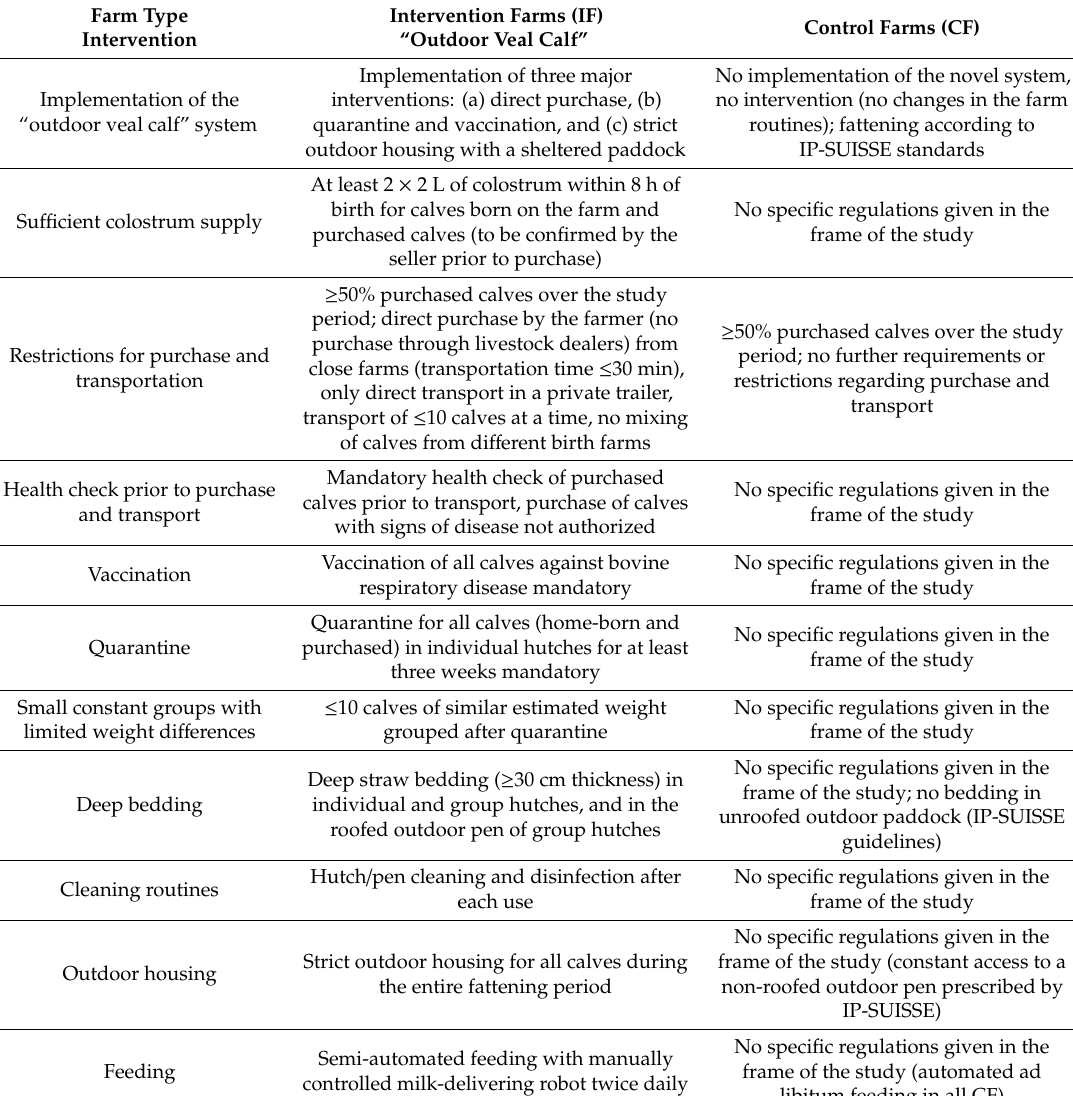
Table 1. Characteristics of the main interventions on intervention farms (IF) implementing the novel system “outdoor veal calf” and corresponding procedures on control farms